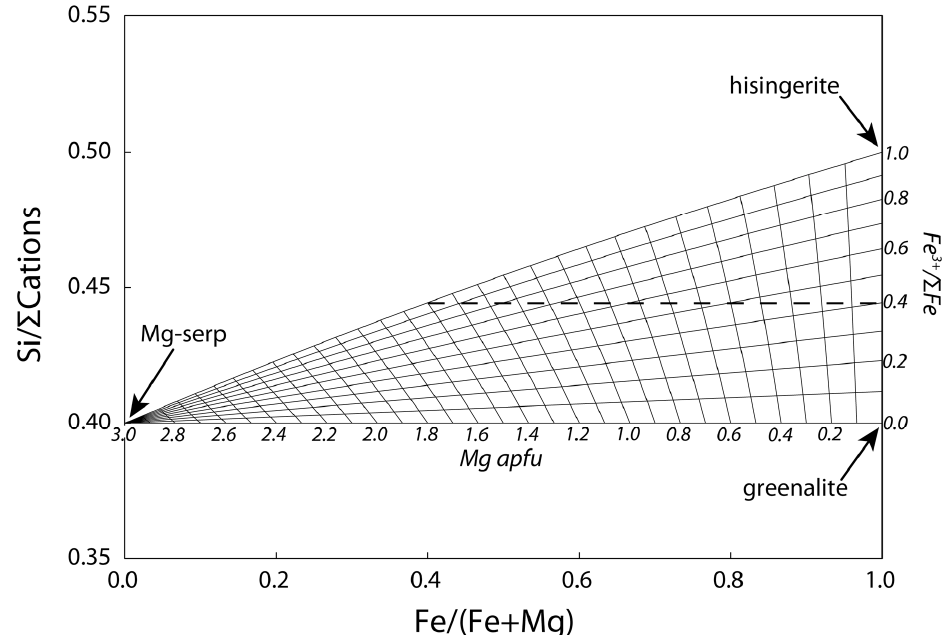
Figure 1. Possible composition space for Mg–serpentine/greenalite/hisingerite solid solutions. Note that the upper compositional limit is slightly curved concave down. Isopleths for Mg and Fe 3+ / Σ Fe refer to a formula unit containing two silicon atoms. The horizontal dashed line at Si/ Σ Cations = 0.444 represents the lower 50% boundary of hisingerite compositions.